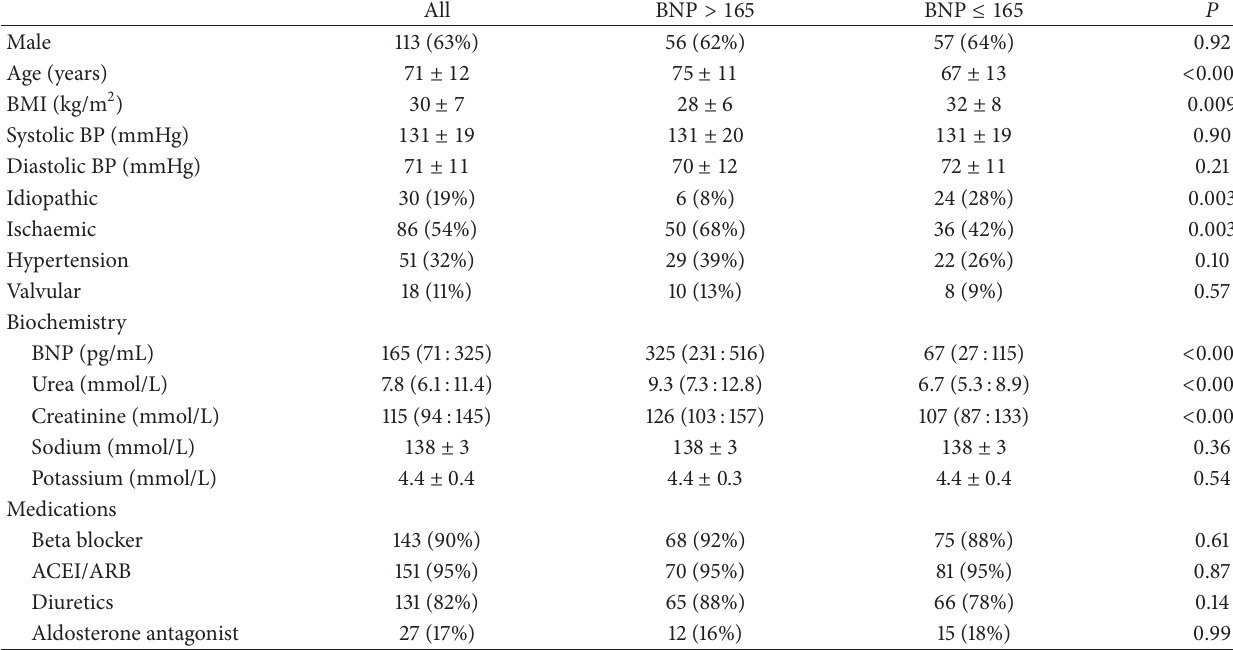
Table 1: Table of demographics and clinical parameters for total population and for the population split by median BNP of 165pg/mL. All BNP > 165